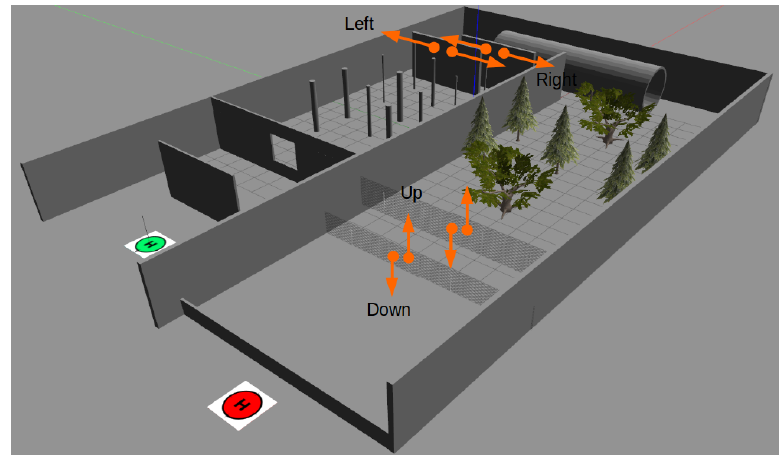
Figure 8. Dynamic training environment (3D view).